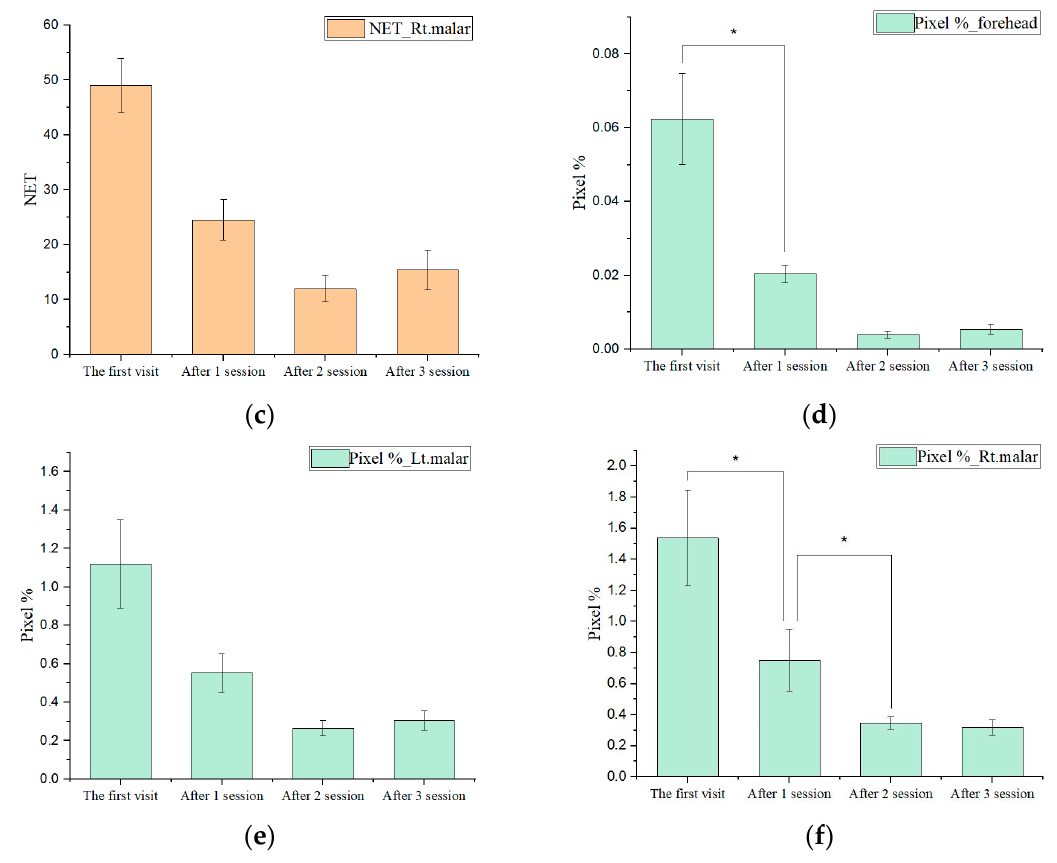
Figure 3. Graphs of NET (number of lesions exceeding the erythema threshold) and pixel % (summation of the area exceeding the erythema threshold) at each session ( a ) NET of the forehead. ( b ) NET of left malar. ( c ) NET of right malar. ( d ) Pixel % of the forehead. ( e ) Pixel % of the left malar. ( f ) Pixel % of the right malar (* p < 0.05).